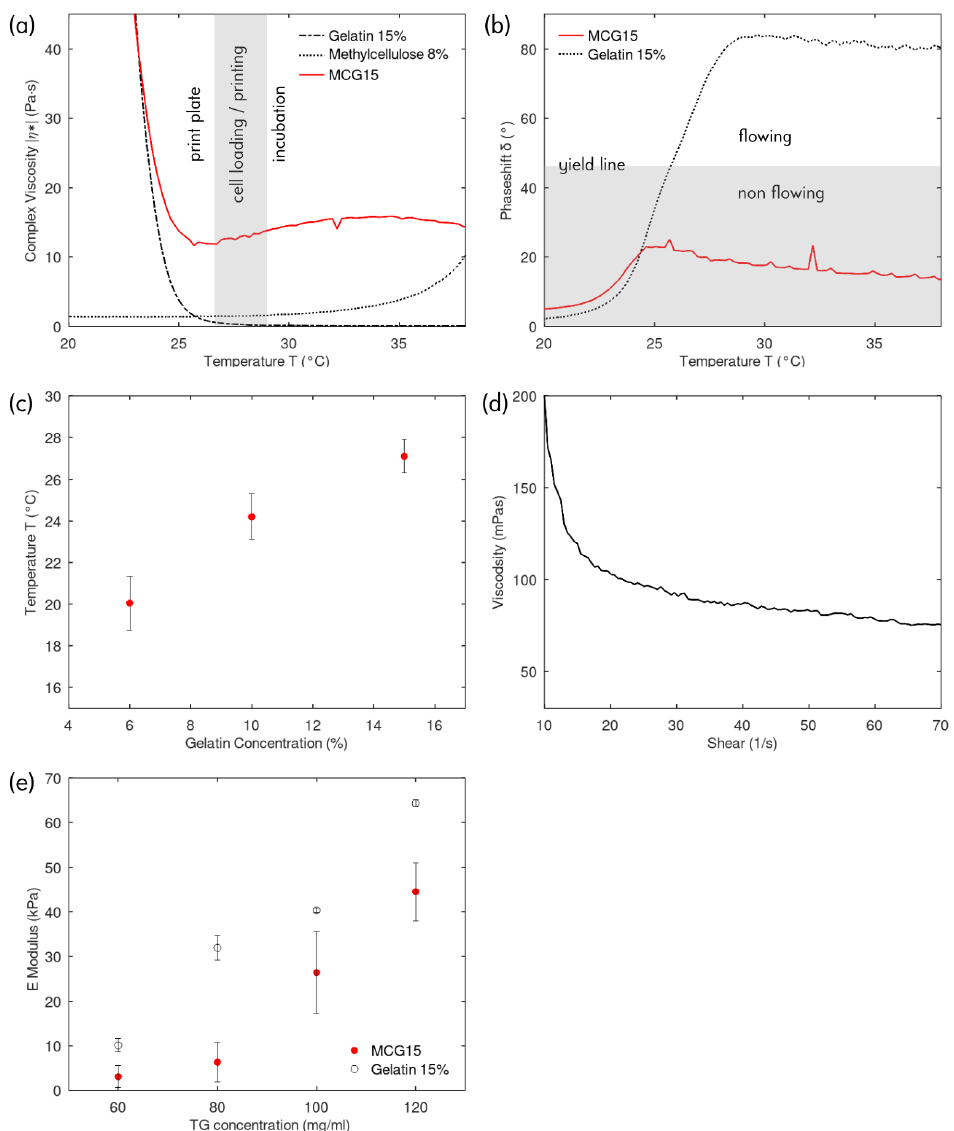
Figure 1. ( a ) Complex viscosity of 15% gelatin, 8% MC and MCG15 in function of temperature, showing the three working regions: (1) instant gelation on the print plate; (2) low viscosity for cell loading and printing; (3) slightly higher viscosity for structural stability at incubation temperatures; ( b ) temperature phase shift during oscillation rheology measurement showing flow and non flow regions for 15% gelatin and corresponding MCG15 ink; ( c ) Yield point in function of gelatin concentration in MCG, e.g., MCG6, MCG10 and MCG15; ( d ) Shear thinning curve of MCG15; ( e ) Nanoindentation elasticity measurements for 15% gelatin and corresponding MCG15 ink for various TG crosslink- ing